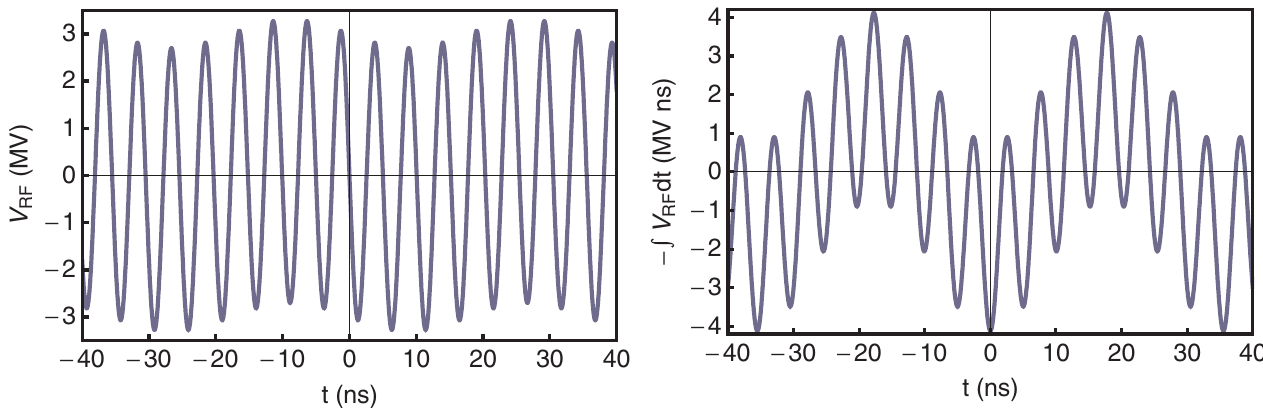
FIG. 5. The rf voltage (parameters given in Table I) and its negative time integral. Since synchrotron radiation is negligible, the synchronous phase is at the origin at V rf (cid:7) 0 .